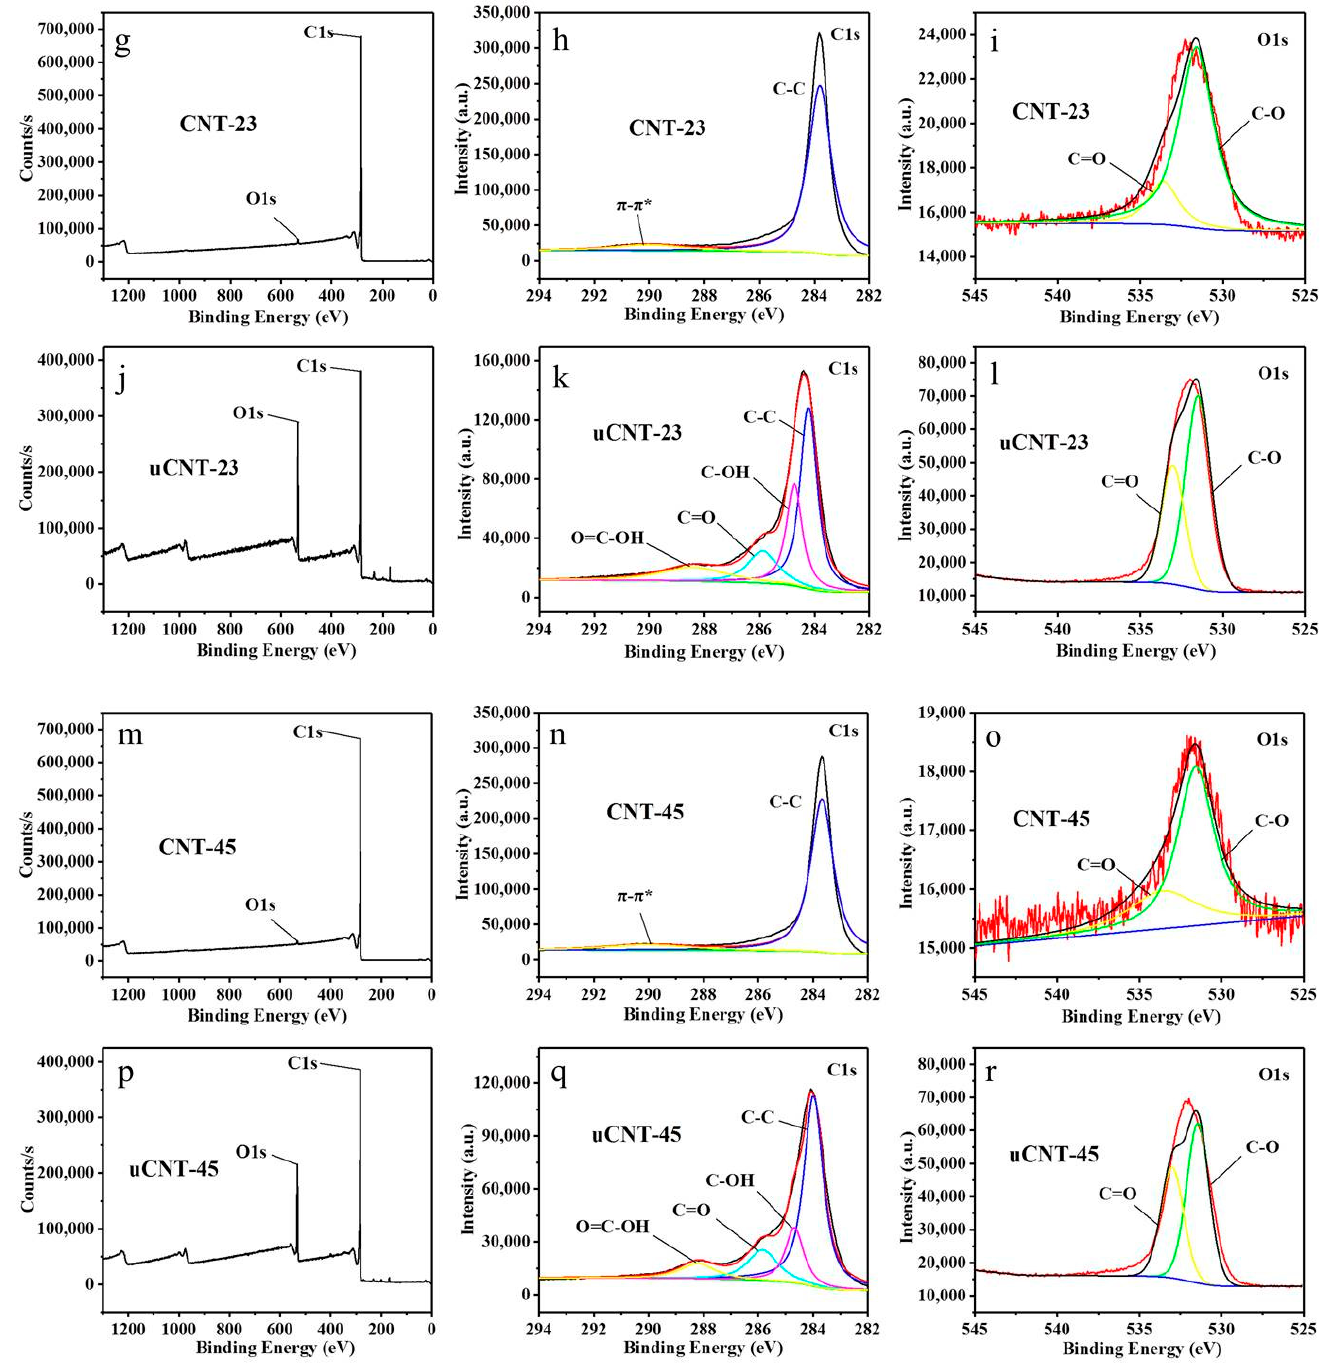
Figure 6. XPS spectra of CNT-15 ( a – c ), uCNT-15 ( d – f ), CNT-23 ( g – i ), uCNT-23 ( j – l ), CNT-45 ( m – o ), and uCNT-45 ( p – r ). Figure 7 shows the UV-Vis spectra of CNTs and uCNTs in an aqueous solution. The UV data show that the maximum absorbance of CNTs and uCNTs was around 255 nm and 260 nm. This maximum is associated with π - π * transition for the C=C bond. For uCNTs, there was also a peak around 330 nm, which corresponds to n- π * for the C=O bond [28]. A comparison of UV-VIS spectra for CNTS and uCNTs gave further confir- mation of introducing the oxygen-containing functional groups in the uCNTs obtained by oxidation with permanganate.